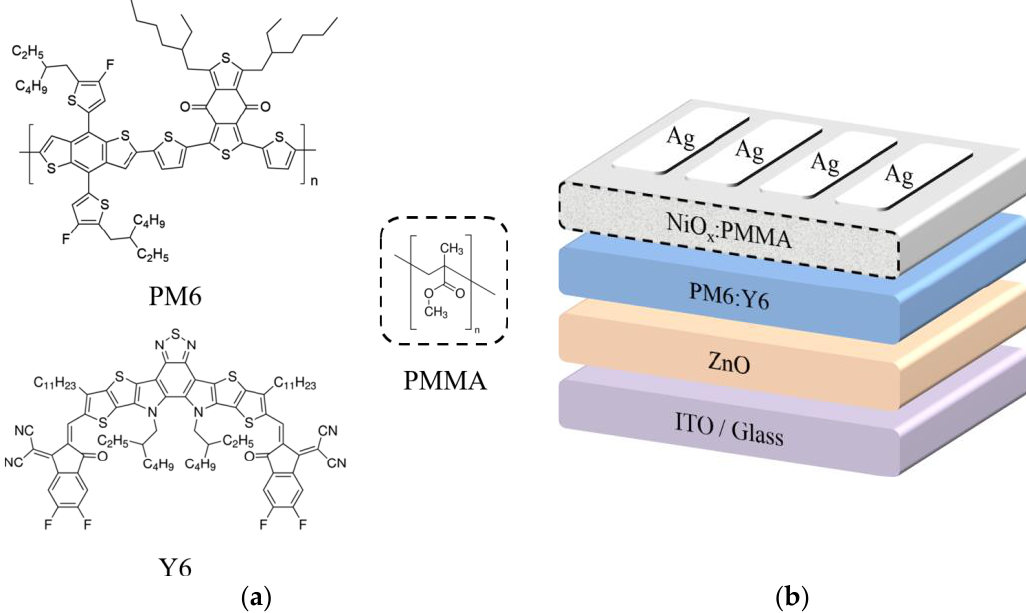
Figure 1. ( a ) Molecular structures of PM6, Y6, and PMMA. ( b ) The device structure of the OSC. To obtain NiO x NP dispersions, nickel chloride hexahydrate (NiCl 2 ·6H 2 O, 2 g, 8.4 mmol) was added to 100 mL ethanol, then stirred at room temperature to obtain a clear green solution. Next, sodium hydroxide (NaOH) solution (5 mol/L) was added to the green solution until the pH value reached 10. The obtained turbid green mixture was cen-